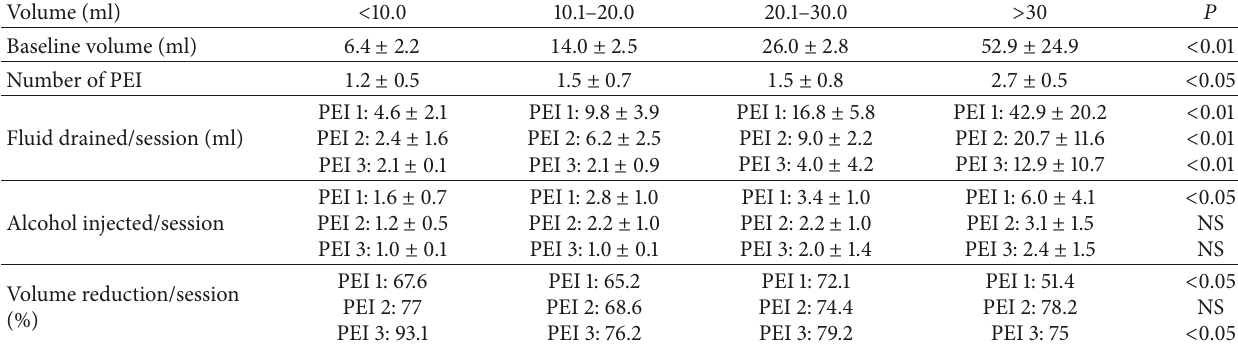
Table 1: Characteristics of thyroid cyst and percutaneous ethanol injection (PEI) procedures.